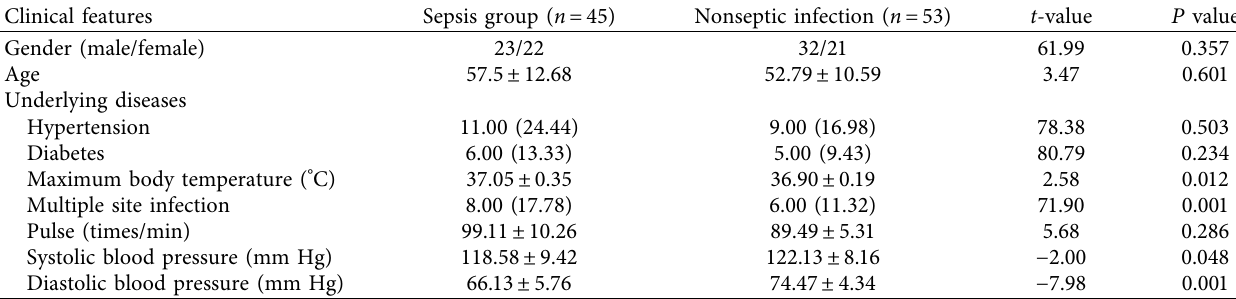
Table 2: Comparison of general clinical data between sepsis and nonseptic infection groups.